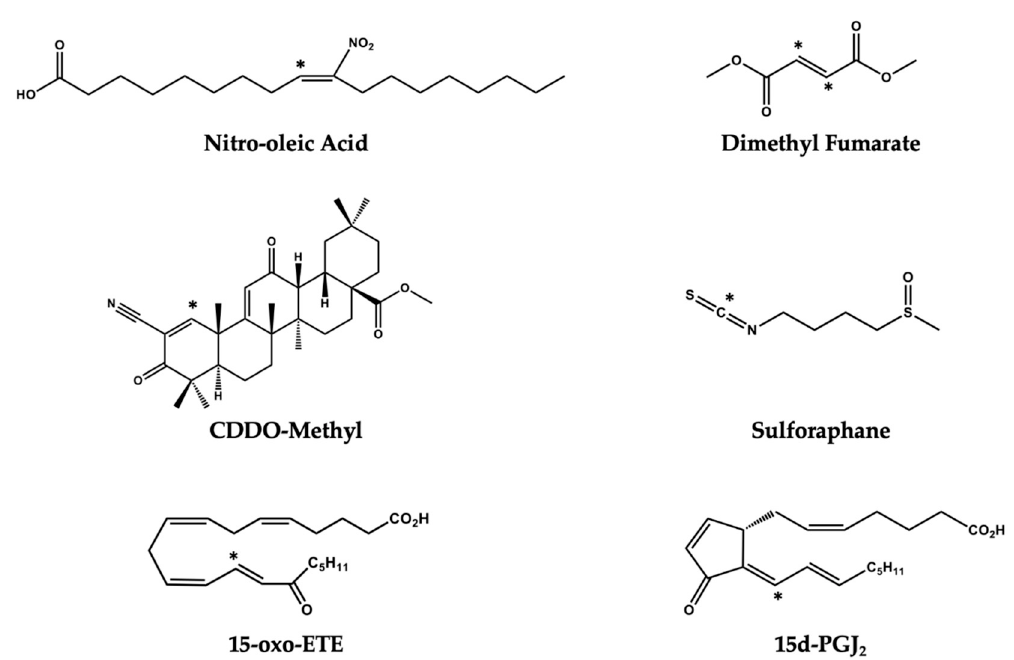
Figure 7. Electrophilic molecules with therapeutic application. Electrophilic carbons on each molecule are denoted with an asterisk (*).